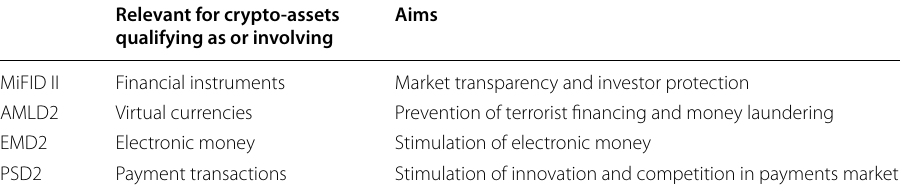
Table 1 Current legislation on crypto-assets Relevant for crypto‑assets qualifying as or